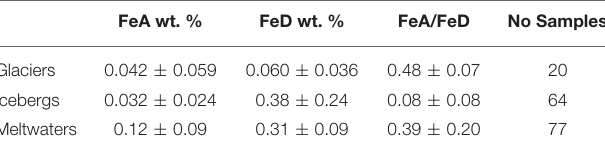
TABLE 3 | Means and standard deviations of FeA and FeD in sediments from glaciers, icebergs and meltwaters. FeA wt. % FeD wt.